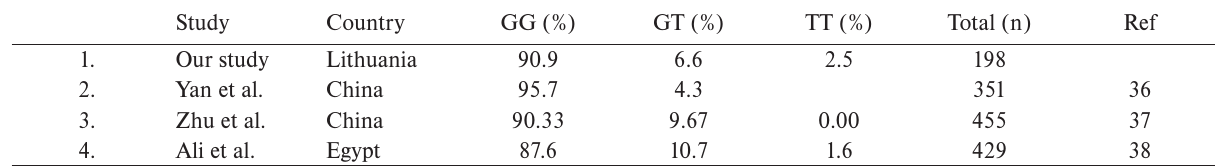
Table 5. Comparison of CYP2J2 rs890293 genotype distribution in control groups of other